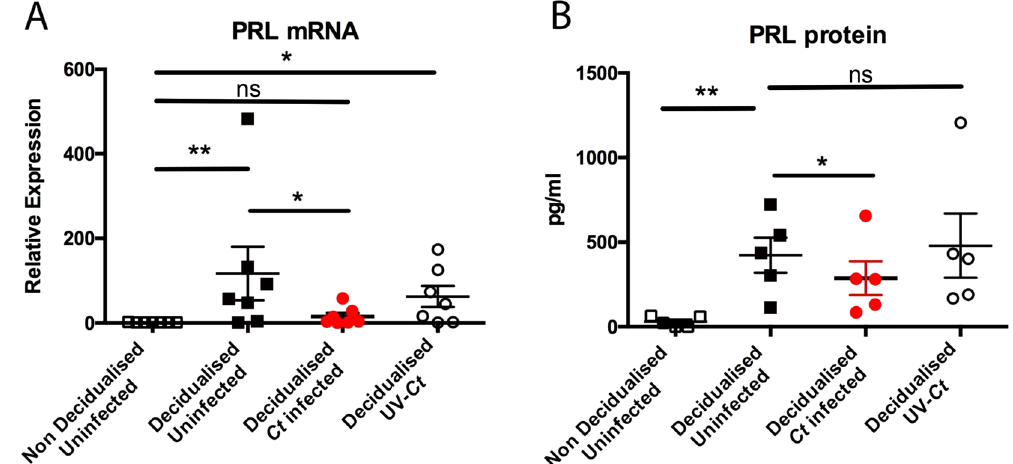
Figure 2. Ct serovar E infection of ESC results in suboptimal decidualisation of ESC. ( A ) PRL mRNA is upregulated in response to decidualisation stimulus, whereas it is downregulated in infected decidualised cells compared to uninfected controls (n = 5, One way ANOVA Friedman’s test with Dunn’s multiple comparisons test, p = 0.0009 and 0.0151 respectively). ( B ) PRL protein levels are increased in decidualised non infected cells compared to non decidualised controls as expected (n = 5, One way ANOVA Friedman’s test with Dunn’s multiple comparisons test, p = 0.0044). Reduction of PRL is observed only in cells infected by Ct compared to decidualised controls, indicating the adverse effect of Ct infection on decidualisation (n = 5, One way ANOVA Friedman’s test with Dunn’s multiple comparisons test, p = 0.028). Each circle/square represents an individual patient.